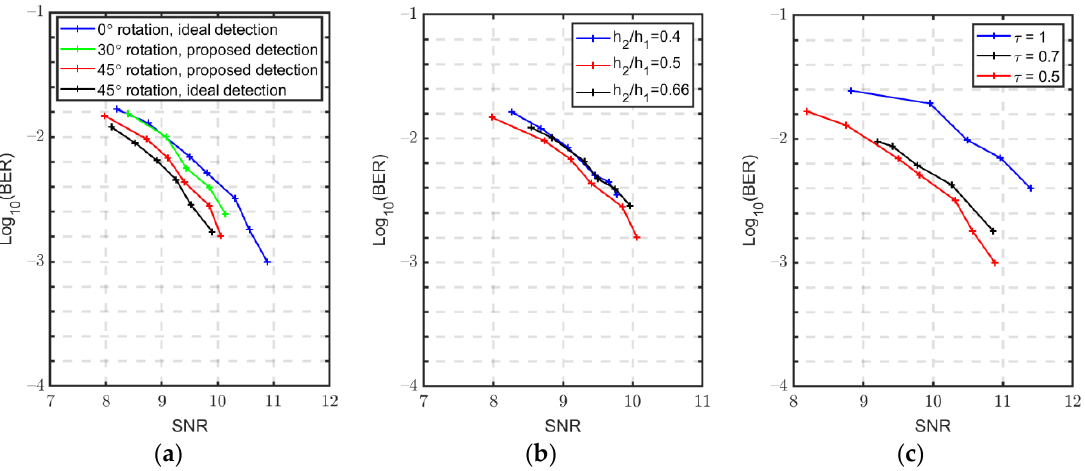
Figure 4. BER of the SM with SSD using the proposed novel active transmitter detection scheme. ( a ) ideal detection vs. the proposed detection. ( b ) Different channel gain distributions. ( c ) Different suppress ratios τ .